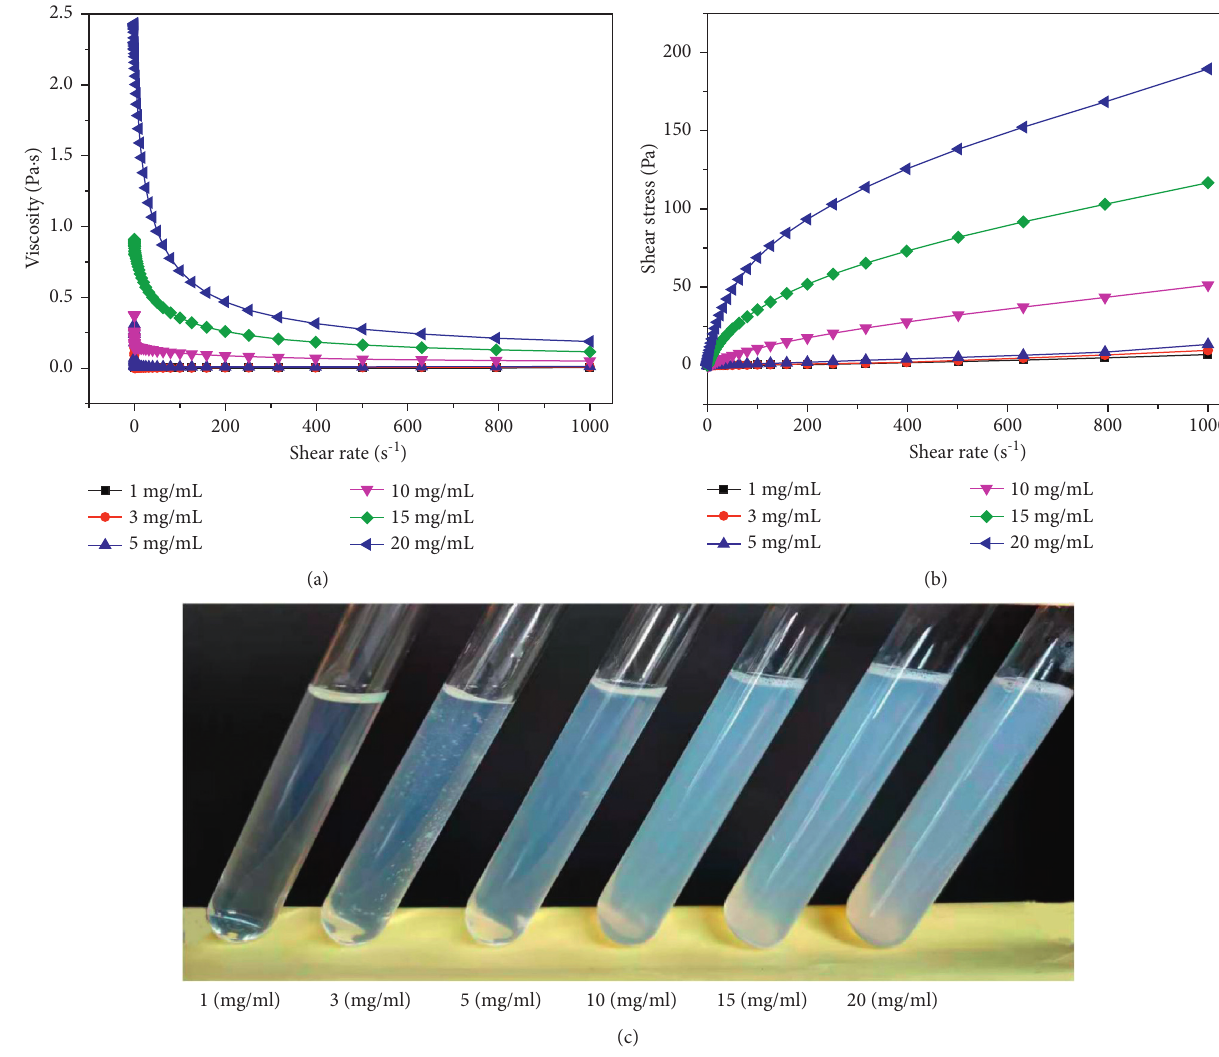
Figure 6: Shear rheology of different concentrations of TSP at 25 ° C: (a) curves of viscosity versus shear rate for TSP solutions with different concentrations (1–20mg/mL), (b) curves of shear stress versus shear rate for TSP solutions with different concentrations (1–20 mg/mL), and (c) photos of TPS solutions at different Table 3: Power-law equations and parameters of the TSP. TSP concentration (mg/mL)